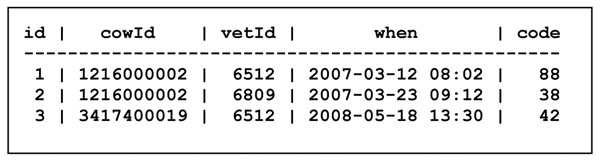
The Clinical table